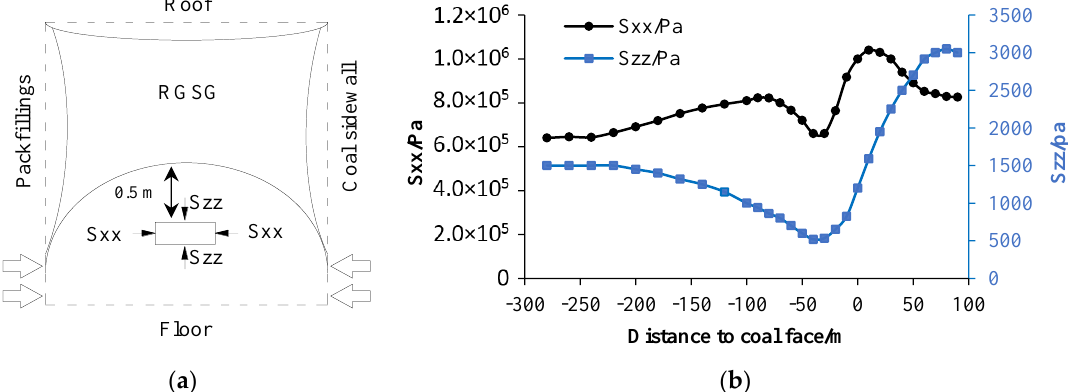
Figure 9. Mechanical model of floor heave ( a ) and variation of the stress in floor ( b ).